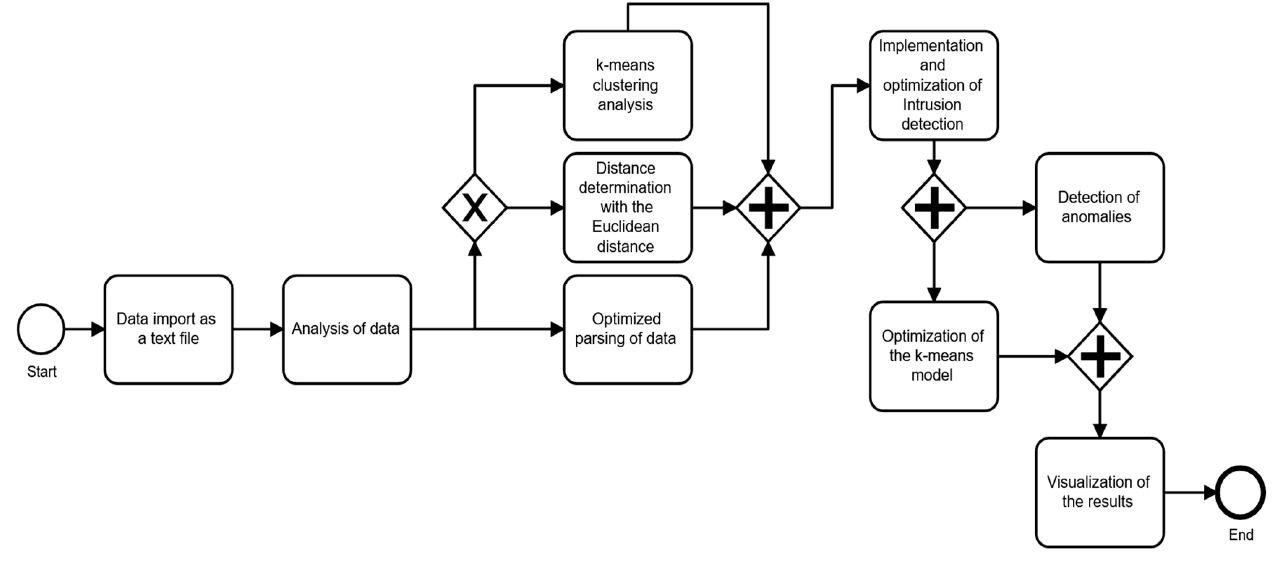
Figure 3. System Framework Diagram.